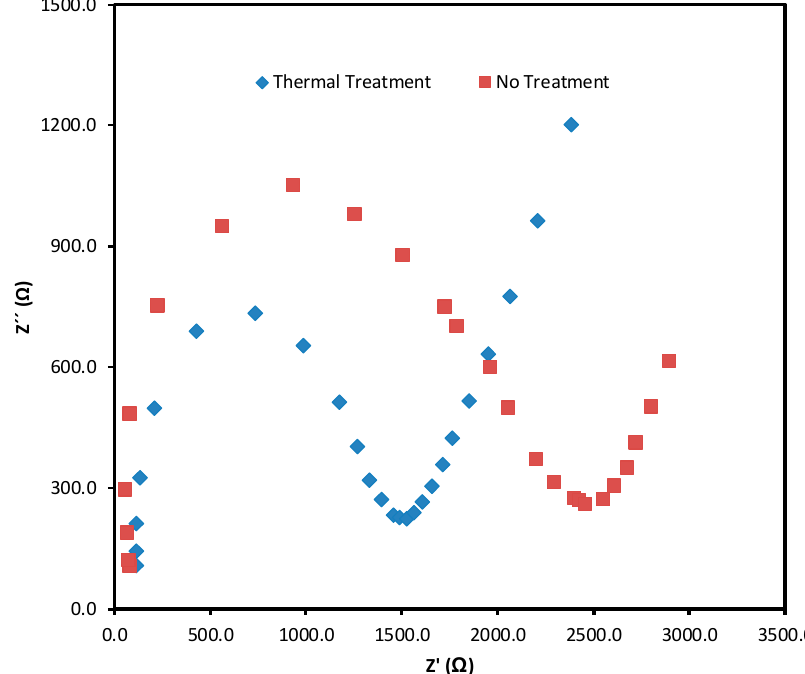
Figure 5. Impedance spectra (Nyquist plots) of the bio-membranes without treatment and with thermal treatment.